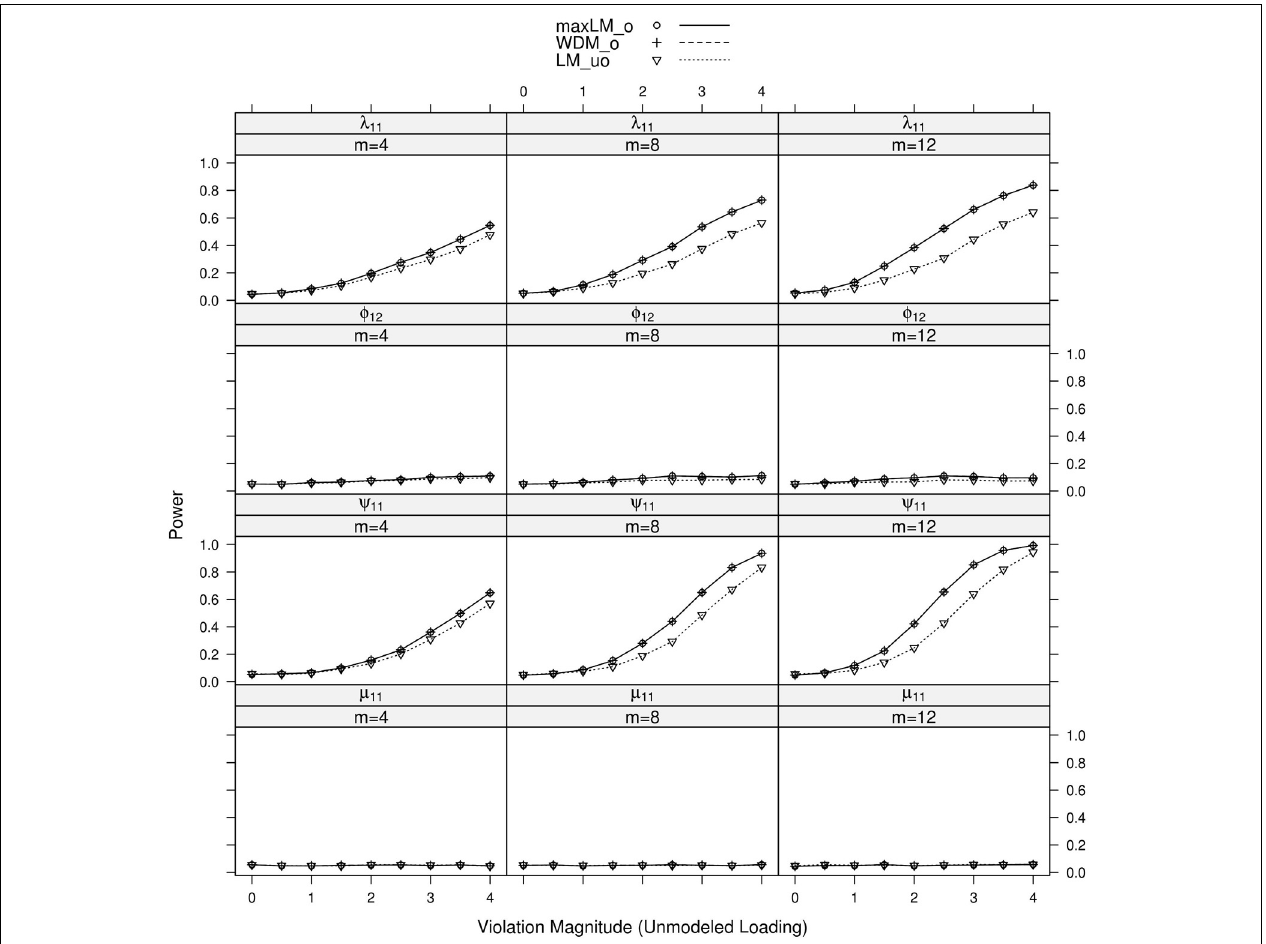
The parameter violating measurement invariance is the unmodeled loading. Panel labels denote the parameter(s) being tested and the number of levels √ n ), Simulation 2. of the ordinal variable m